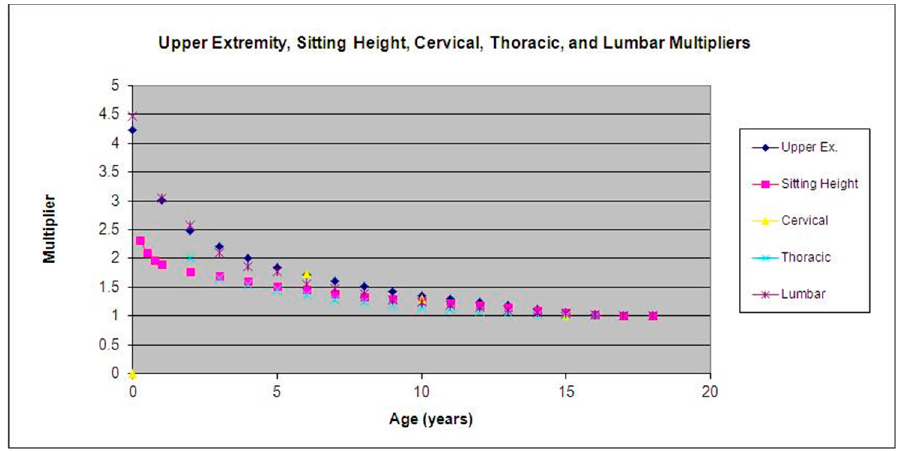
Figure 3. Upper extremity, sitting height, cervical, thoracic, and lumbar